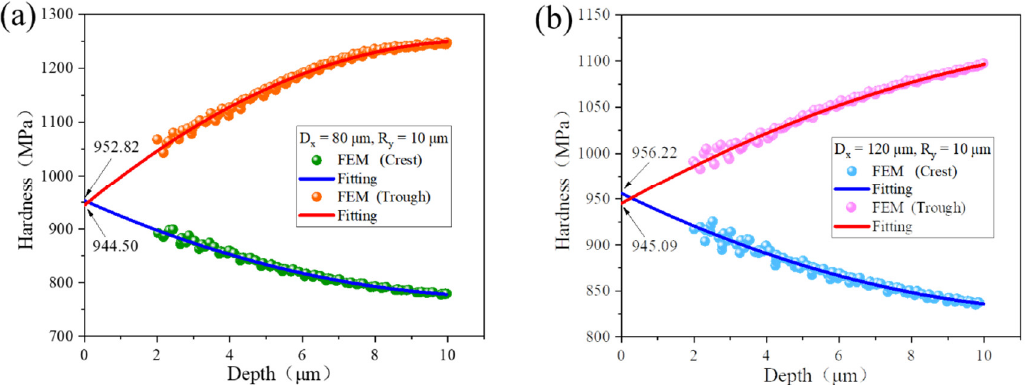
Figure 12. Hardness regression of crest and trough. ( a ) D x = 80 μm and R y = 10 μm; ( b ) D x = 120 μm and R y = 10 μm.